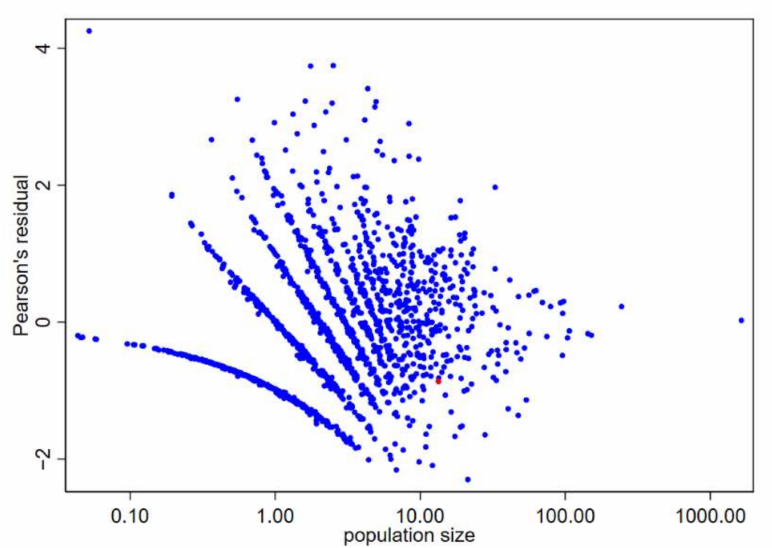
Figure 6. Scatter plot of the specific heterogeneity terms vs. shared components ( 1 ovarian cancer from model 4 (M4) in four municipalities. Lombardy Region, 2000–2018. Blue: Rosate; orange: Calcio; green: Broni. Fifty thousand draws from the joint posterior distribution.